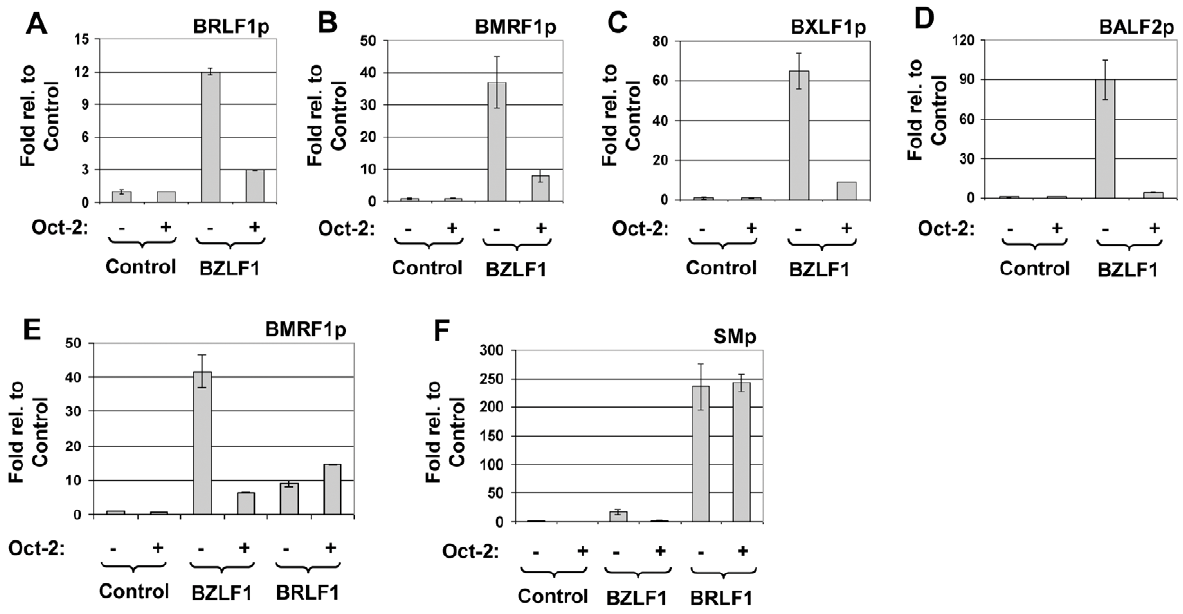
Figure 3. Oct-2 inhibits BZLF1 activation of multiple lytic EBV promoters in EBV-negative cells. EBV-negative HONE-1 cells were transfected with (A) BRLF1p-luciferase construct, (B) BMRF1p-luciferase construct, (C) BXLF1p-luciferase construct, or (D) BALF2p-luciferase construct in the presence or absence of co-transfected BZLF1 (5 ng), Oct-2 (100 ng), or control vectors as indicated. The fold luciferase activity for each condition is shown relative to control vector; the value for the activity of the promoter construct plus the vector control is set at 1. Values are given as means 6 standard deviations of results from two replicates. EBV-negative HONE-1 cells were transfected with the (E) BMRF1p-luciferase construct or (F) SMp-luciferase construct in the presence or absence of co-transfected BZLF1 (5 ng), BRLF1 (5 ng), Oct-2 (100 ng), or control vectors as